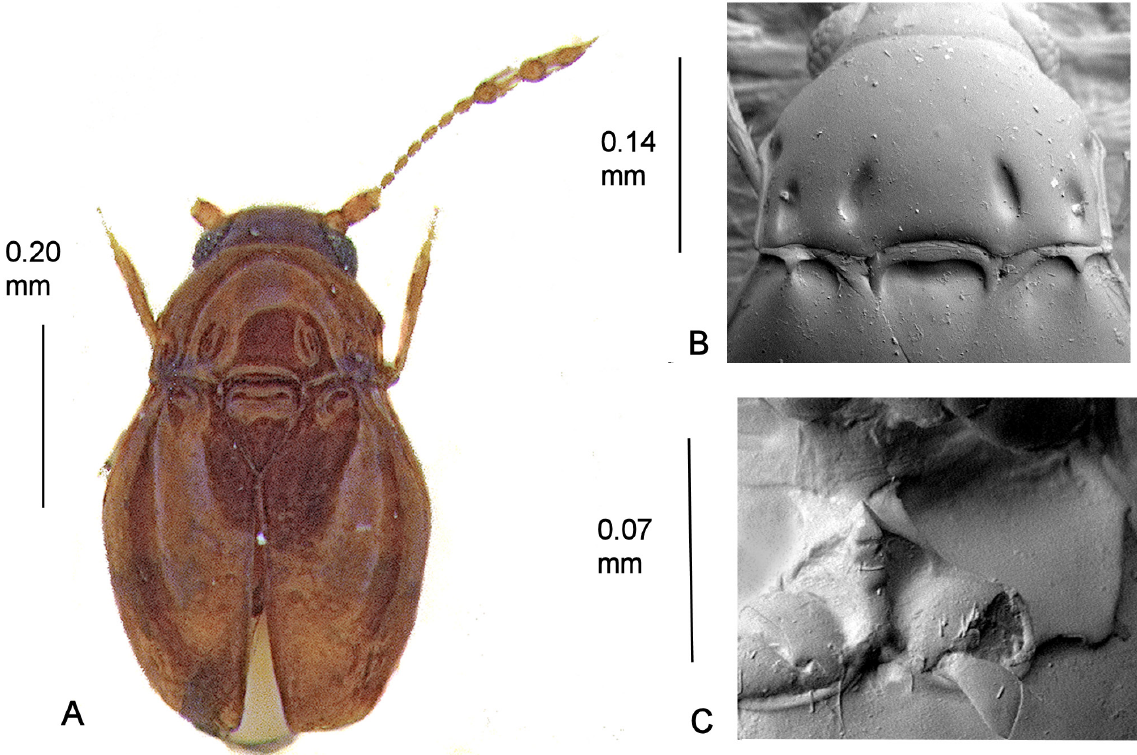
Fig. 11 . Cissidium lucidulum sp. nov. A . Habitus. B . Pronotum, × 670. C . Mesoventrite showing median process of collar, mid-keel, keel and angular lateral margin without serrations,